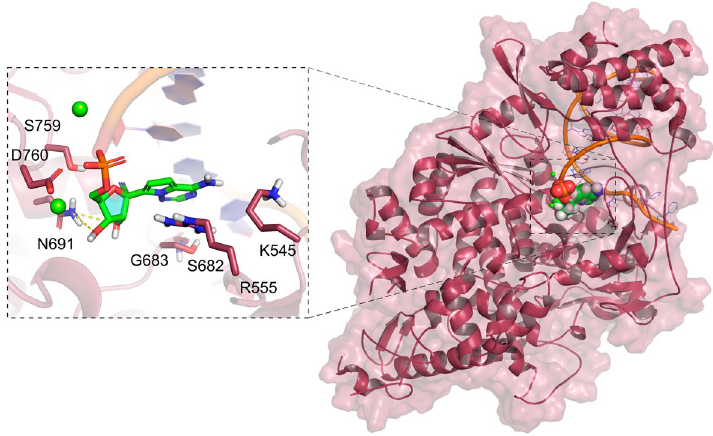
Figure 3. Structure of the Nsp12 complexed with remdesivir and an RNA primer (PDB code 7BV2, ligand coloured greed and RNA represented as an orange cartoon). Mg 2+ ions are represented as green spheres. The protein–ligand hydrogen bonds are represented as yellow dashed